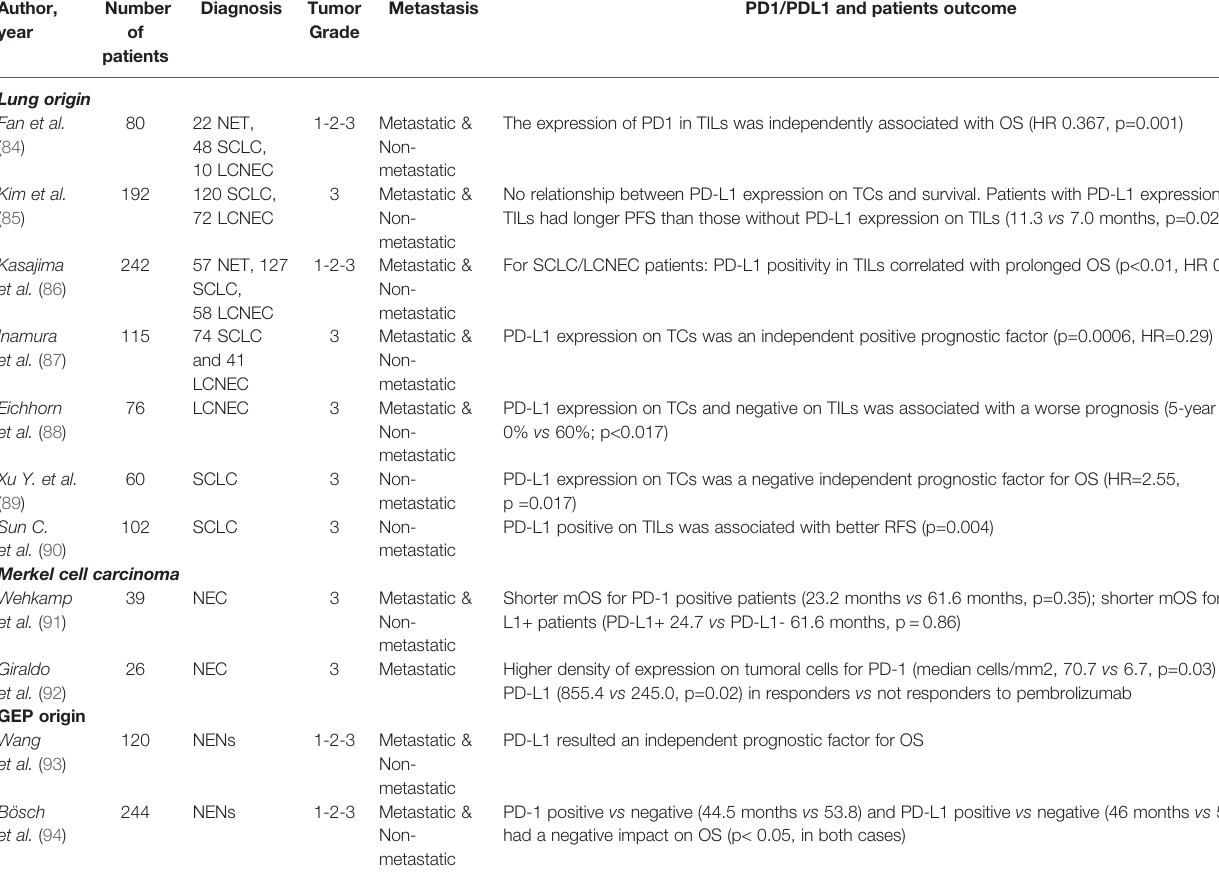
TABLE 3 | Prognostic values of programmed cell death protein 1 receptor (PD1) and programmed death-ligand 1 (PD-L1) in NENs